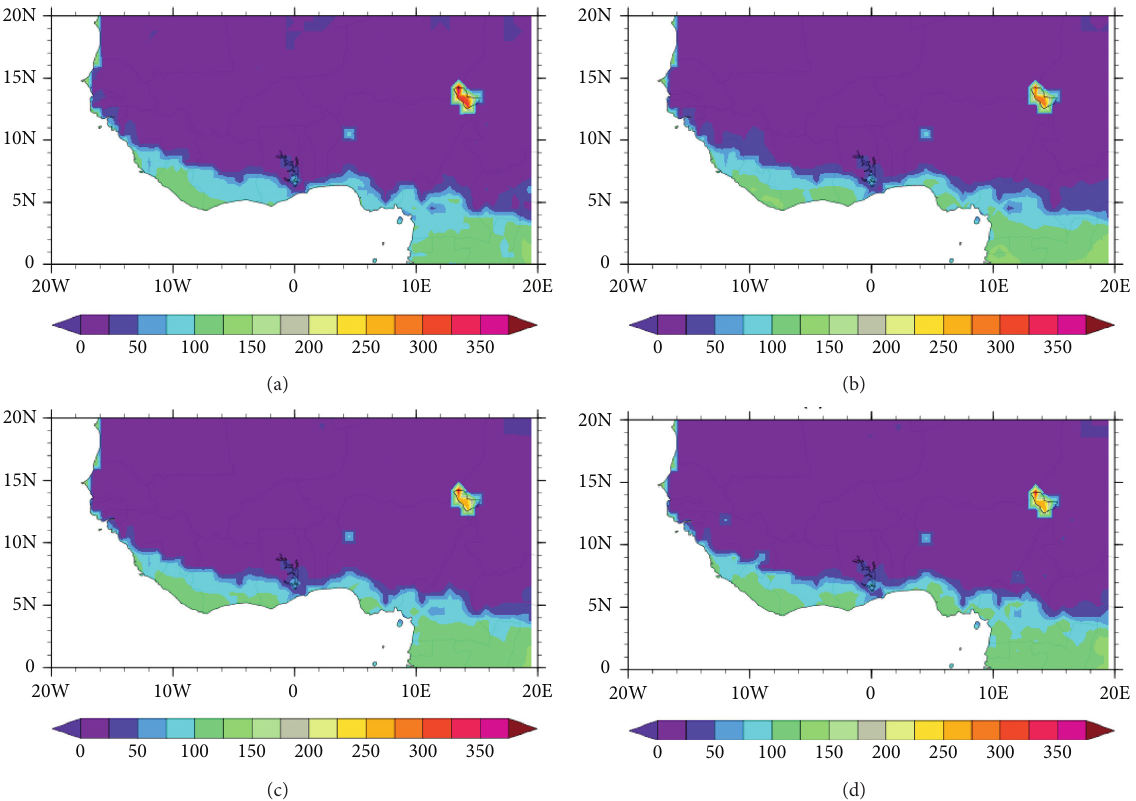
Figure 18: Spatial distribution of surface latent heat (w/m 2 ) for Dec.16 th , 2011–Feb. 28 th , 2012. (a) Naoh. (b) CLM4. (c) NaohMP. (d) NoahMP